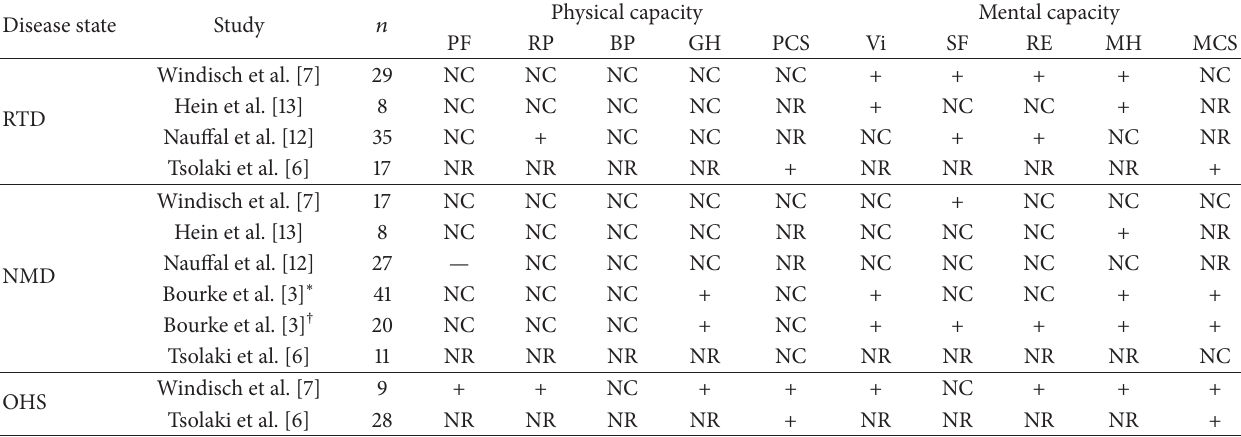
Table 3: Change in SF-36 domains at 12 mo with home ventilation compared to baseline across studies and disease states. Disease state